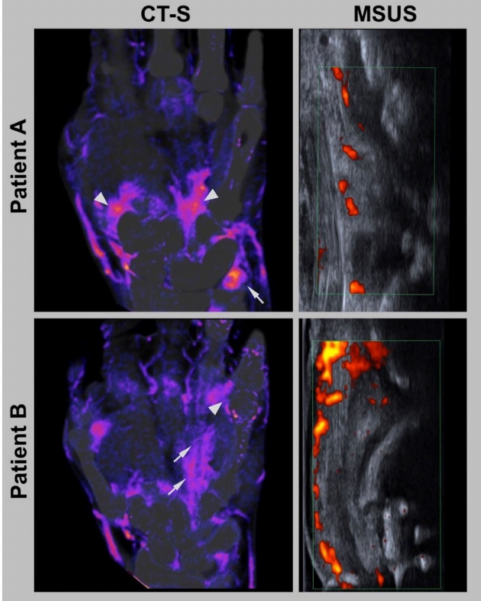
Figure 4. Patient examples. CT-S = conventional CT subtraction for 80 kVp, MSUS = musculoskeletal ultrasound of the wrist (Patient A) and of the metacarpophalangeal (MCP) joint V from the dorsal view (Patient B). Patient A: Imaging examples of a 75-year-old male patient with CPPD. CT-S and MSUS showed severe synovitis in the wrist (arrowhead) and on the processus styloideus ulnae (arrow). Patient B: Imaging examples of a 62-year-old man patient with seronegative rheumatoid arthritis. Severe synovitis was detected at the MCP V joint in CT-S and MSUS (arrows). Furthermore, CT-S showed severe tenosynovitis of the ring finger